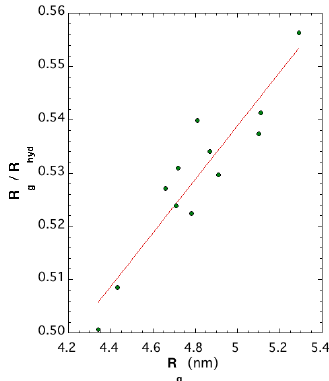
Figure 7. Ratio R g / R hyd versus radius of gyration of the 12 structural